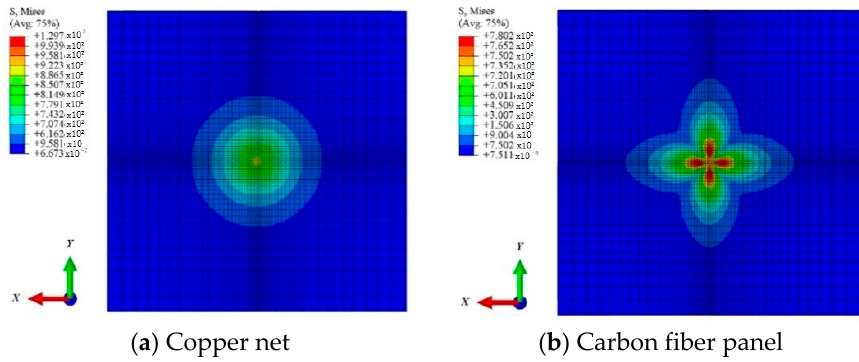
Figure 4. Stress nephogram of 200 kA multi-field coupling simulation.